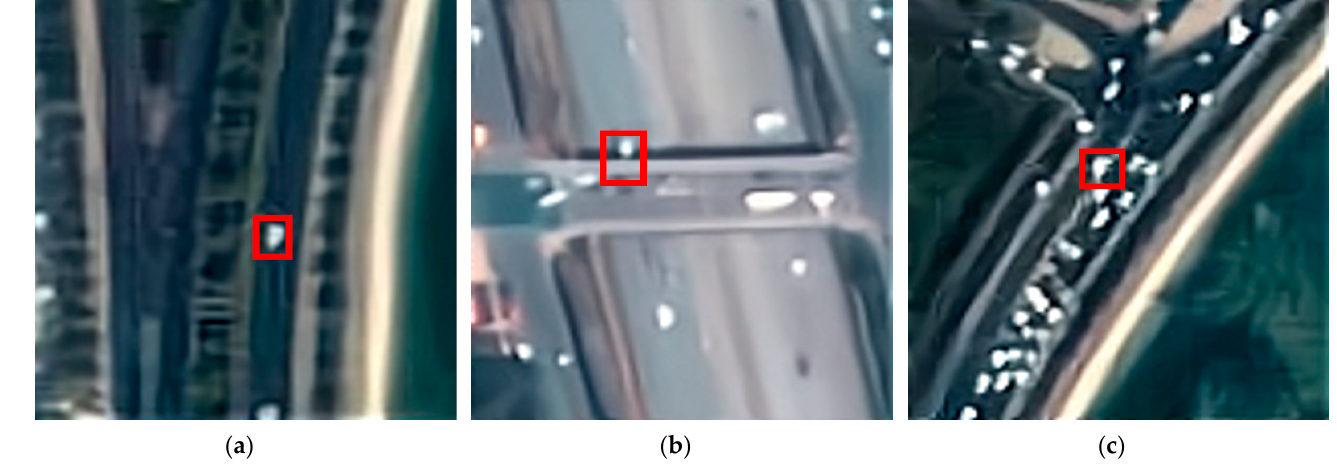
Figure 1 . The object to be tracked is surrounded by the red box . Satellite images where object is ( a ) Figure 1. The object to be tracked is surrounded by the red box. Satellite images where object is small, ( b ) occluded and ( c ) similar to the background. ( a ) small, ( b ) occluded and ( c ) similar to the